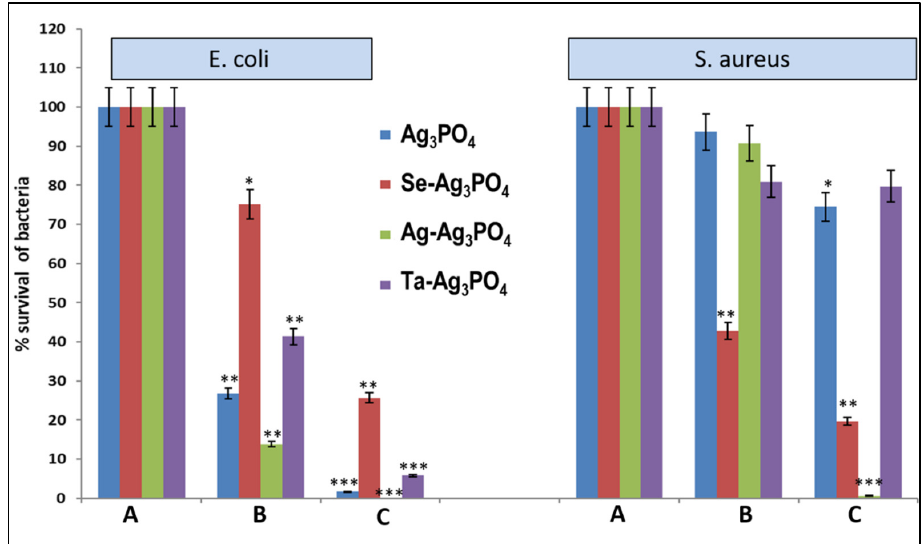
Figure 9. Effects of tested compounds on E. coli and S. aureus growth. A: control i.e., without nano- particles and sonication; B: Treated with sub-MIC value of nanoparticle but without sonication; C: Treated with sub-MIC value of nanoparticle and sonication. * p < 0.05, ** p < 0.001; *** p < 0.0001.